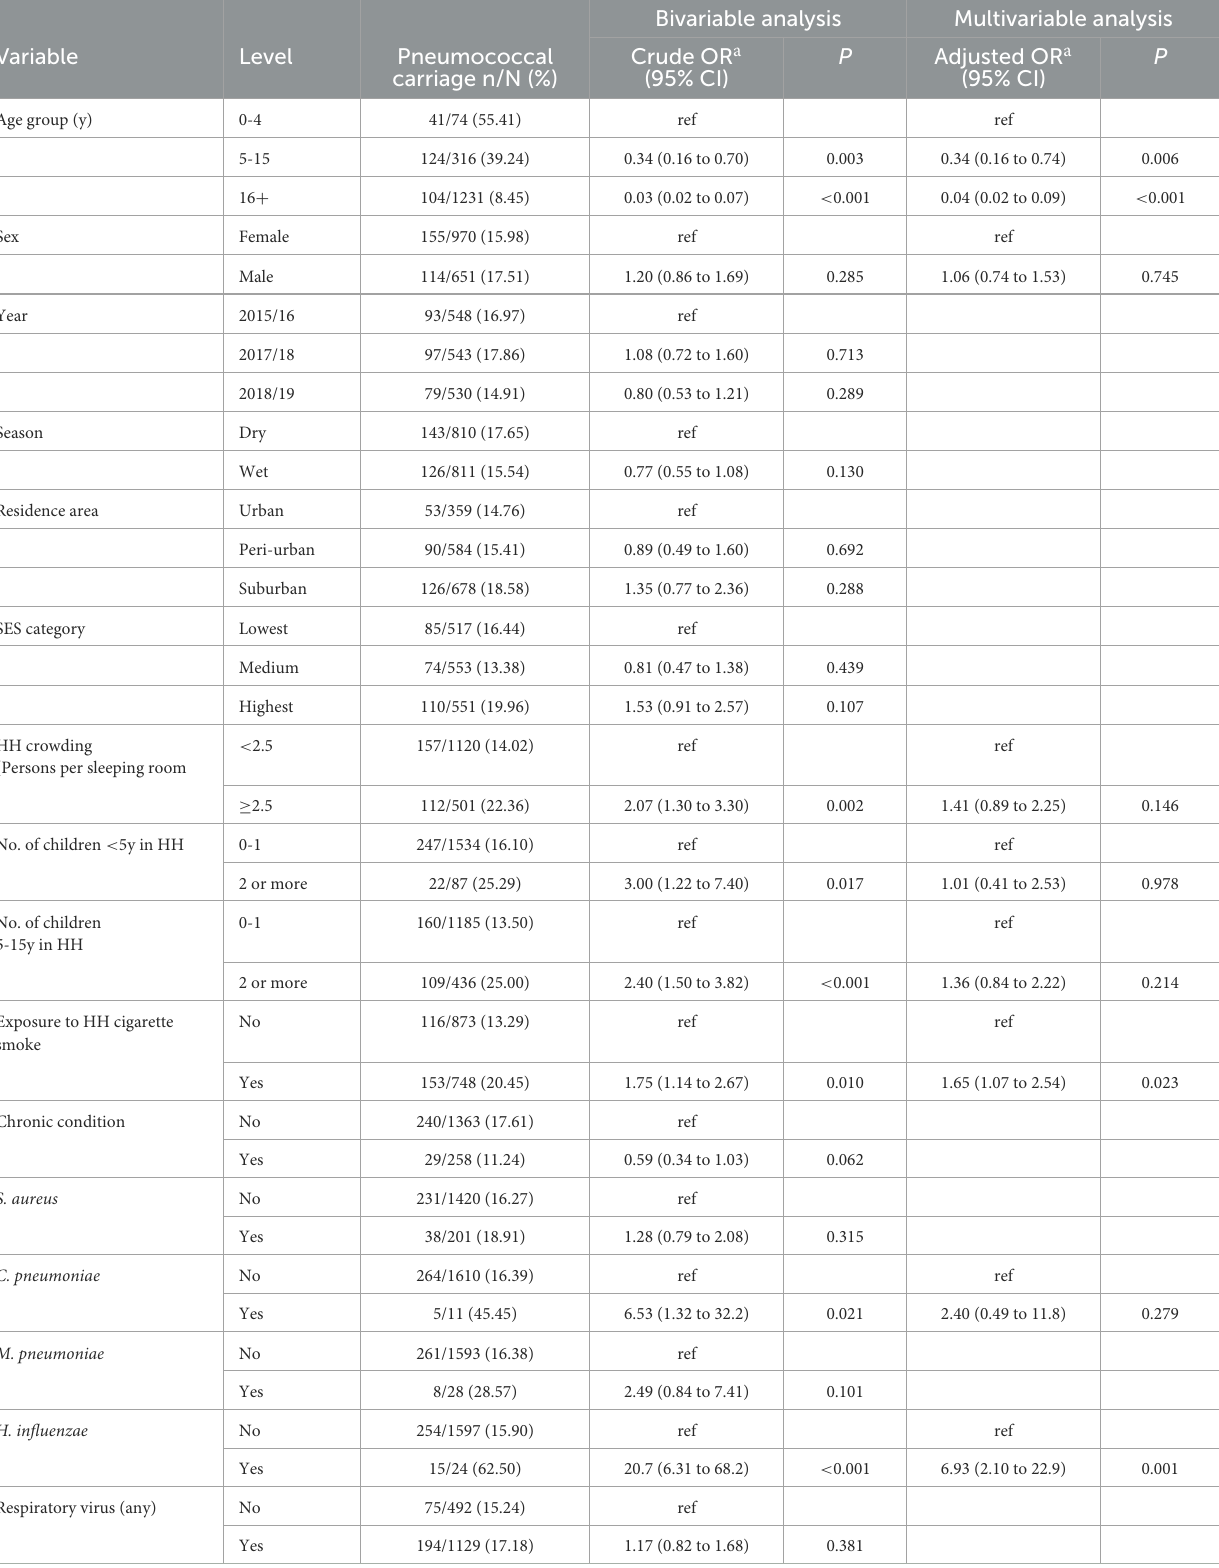
TABLE 1 Bivariable and multivariable analyses for associations with nasopharyngeal pneumococcal detection among influenza-like illness cases ( n = 1,621).